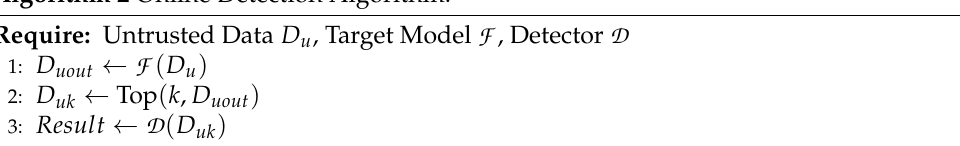
Algorithm 2 Online Detection